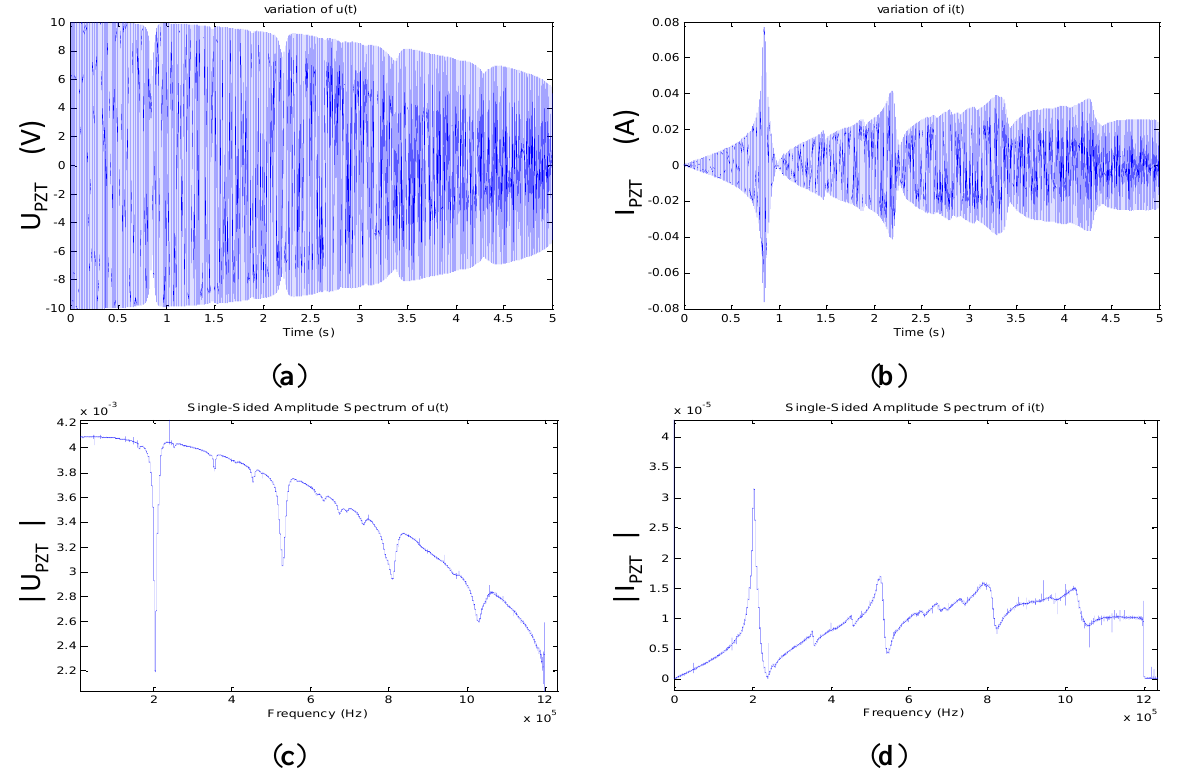
Figure 5. ( a ) V (t): Voltage response of the PZT patch to a chirp of 5 s going from 0 Hz PZT to 1.2 MHz ( b ) I (t): current response of the PZT patch to a chirp of 5 s going from 0 Hz PZT to 1.2 MHz ( c ) V (f) = FFT[V (t)] Voltage spectral response of the PZT to the PZT PZT